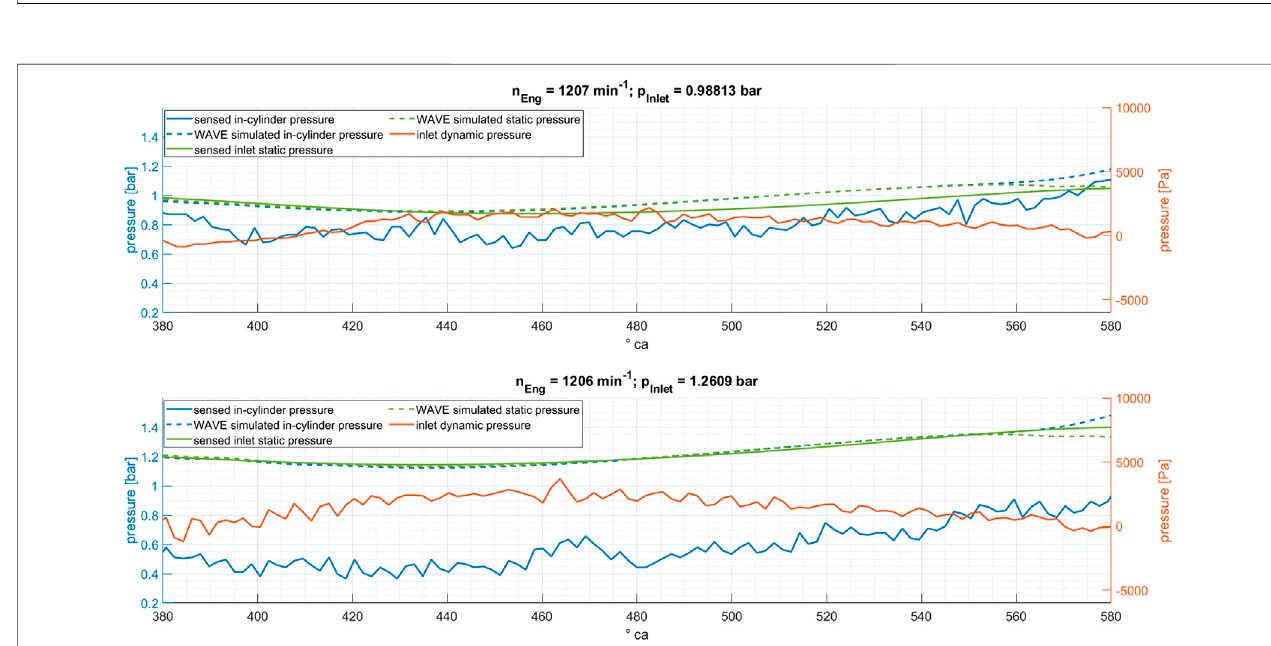
FIGURE10| Thestatic anddynamicpressure intheinlet duct alongwiththe in-cylinder pressurezooming inthe intakevalve opening durationat the enginespeed of 1,200 rpm. Top graph: naturally aspirated mode; Bottom graph: boosted conditions.